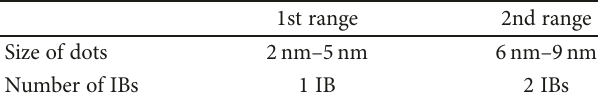
Ga As QDIBSC dot for di ff erent dot sizes of (a) 1 nm, (b) 2 nm, (c) 5 nm, and (d) 6 nm. 0.53 0.47 Table 2: Ranges of dot size which vary the number of